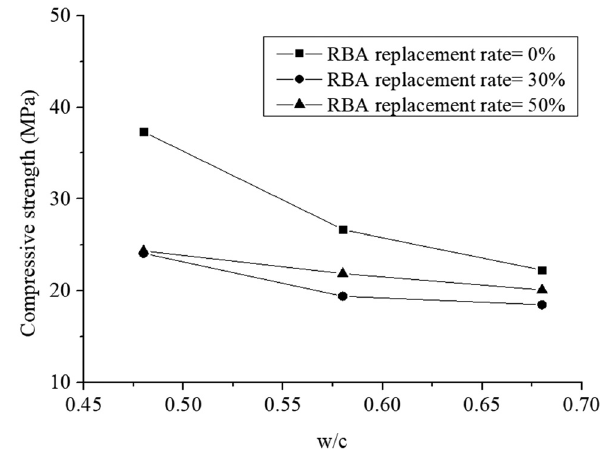
Figure 6: Compressive strength versus